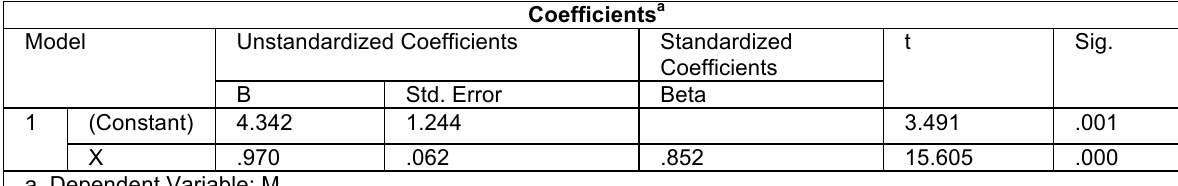
Table 3: Coefficients Substruktur 1 (Model